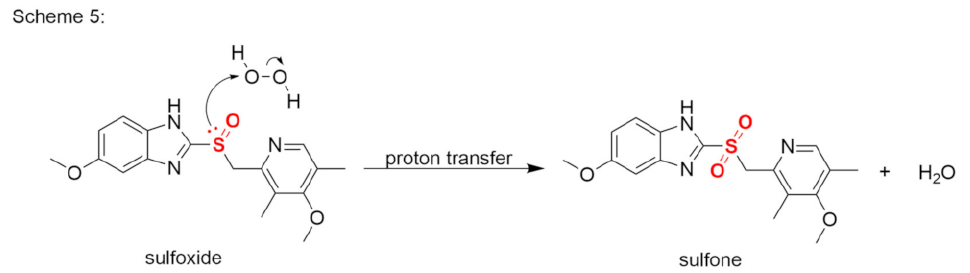
Figure 6. Reaction between a sulfoxide and hydrogen peroxide (Scheme